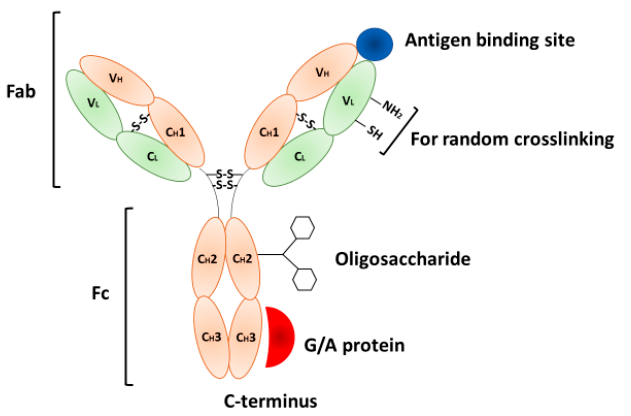
Figure 1. The scheme of the structure of the antibody. G/A proteins specifically interact with the Fc part. -NH2 and -SH groups are used for random covalent immobilization of Abs. Adopted from Li and Chen [26].